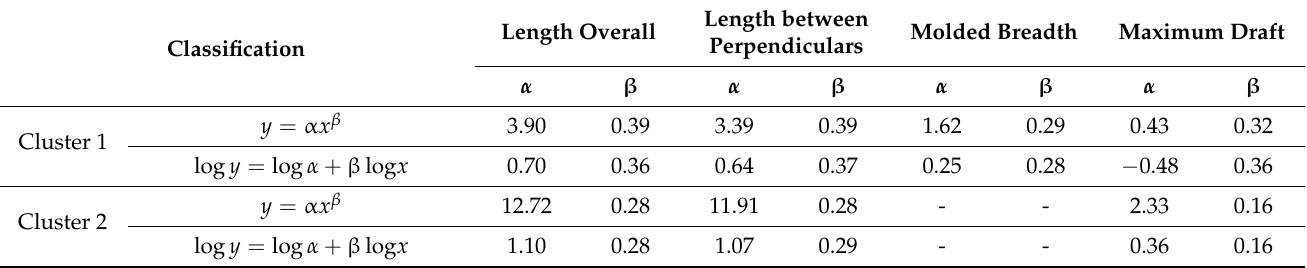
Table 6. Comparison of change in length variable according to DWT increase in Clusters 1 and